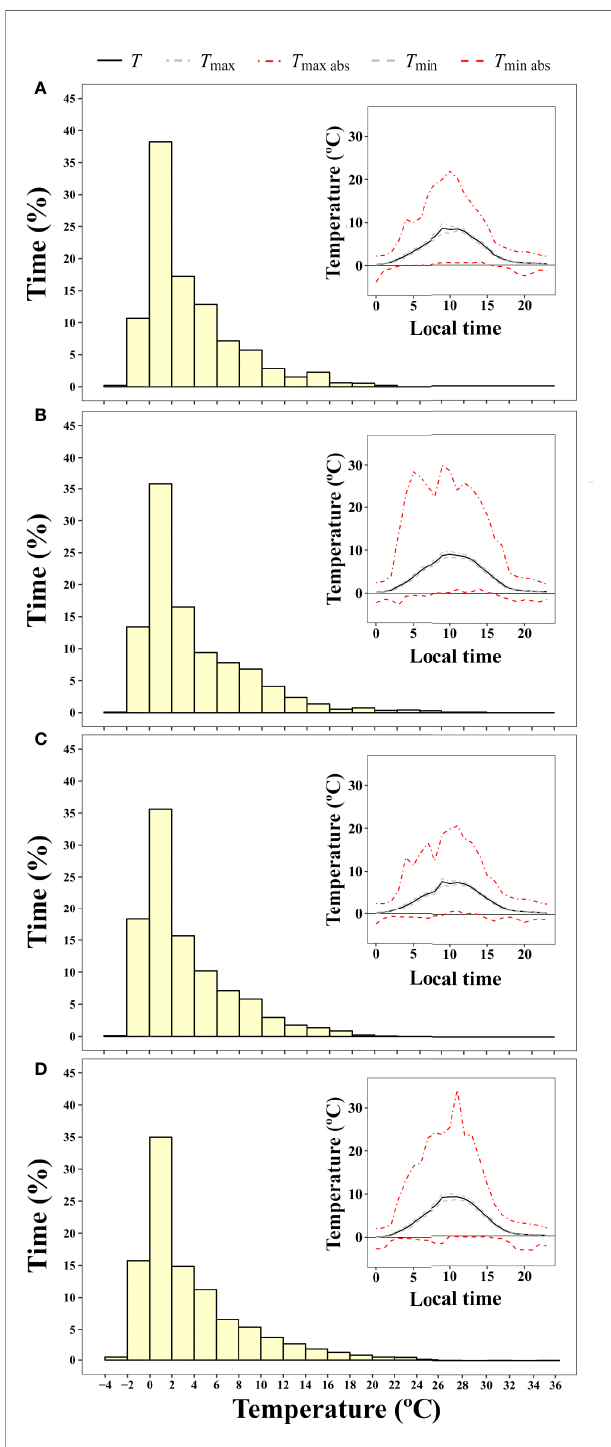
DC FIGURE 5 | Frequency of time (% of hours) during which a certain two degree interval of surface temperature was experienced by (A) B. pseudotriquetrum , (B) C. aciphyllum , (C) P. alpinum , and (D) S. uncinata averaged for 20 days over the 2019 summer season (from 07/01/2019 to 29/ 01/2019). Thermocouple dataloggers were placed in moss beds at three to nine locations per species around Ardley Island. Inset graphs show diurnal course of surface